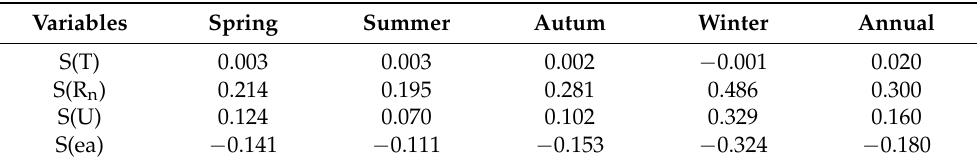
Table 5. The mean Sensitivity coefficients for mean temperature, solar radiation, wind speed, vapor pressure in the whole basins of Wei River Basin, which were represented as S(T), S(R n ), S(U) and S(ea),